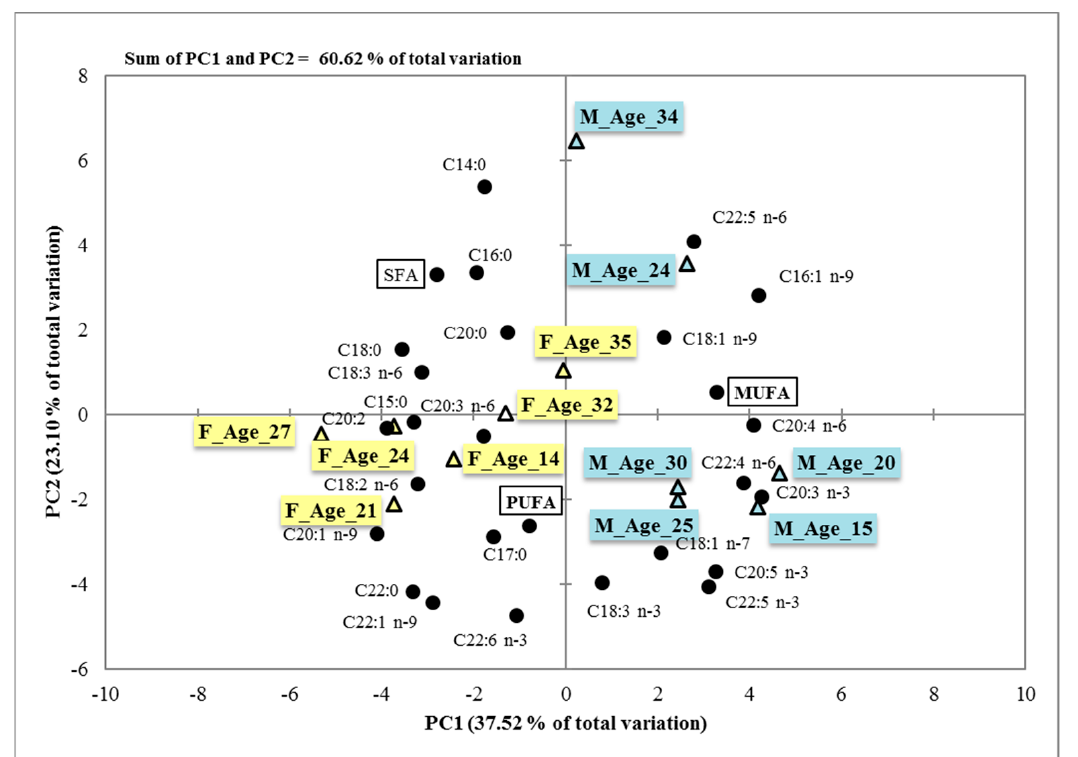
Figure 2. PCA factor-scores biplots, explaining the two components score (PC1 and PC2) for the samples of wild boar’s meat and display grouping similarities between samples according to their fatty acids concentration. SFA = Saturated Fatty Acids, MUFA = Monounsaturated Fatty Acids, PUFA: Polyunsaturated Fatty Acids; F_Age (14, 21, 24, 27, 32, 35): samples from female wild boars aged 14 to 35 months; M_Age (15, 20, 24, 25, 30, 34): samples taken from wild boar males aged 15 to 34 months.